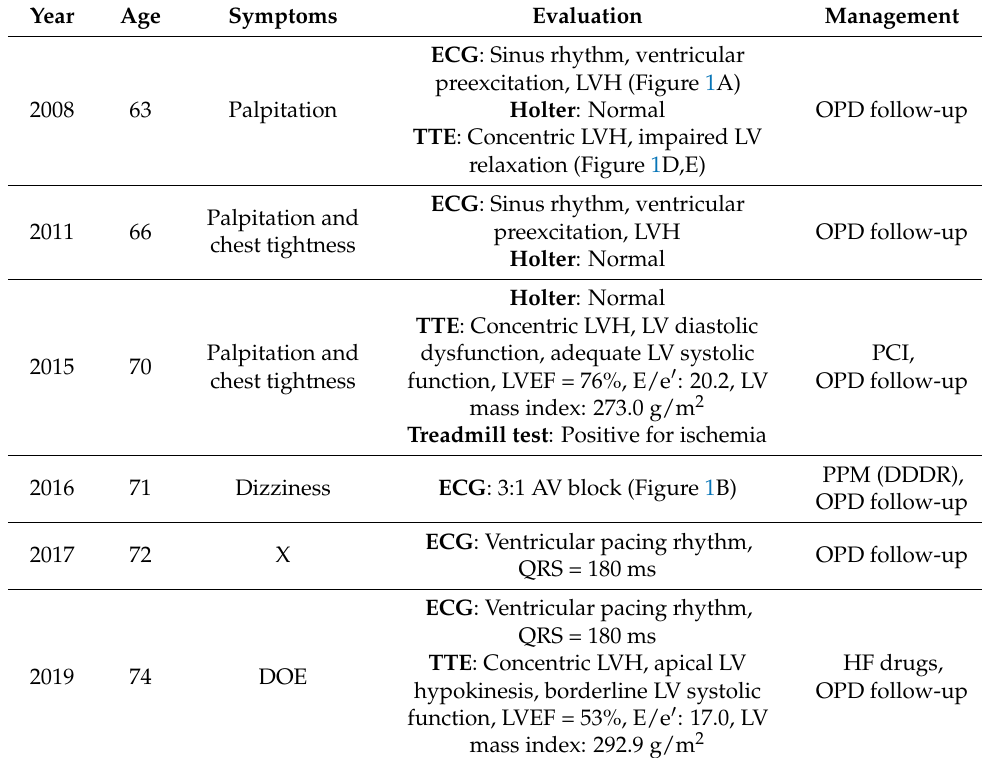
Table 1. Clinical